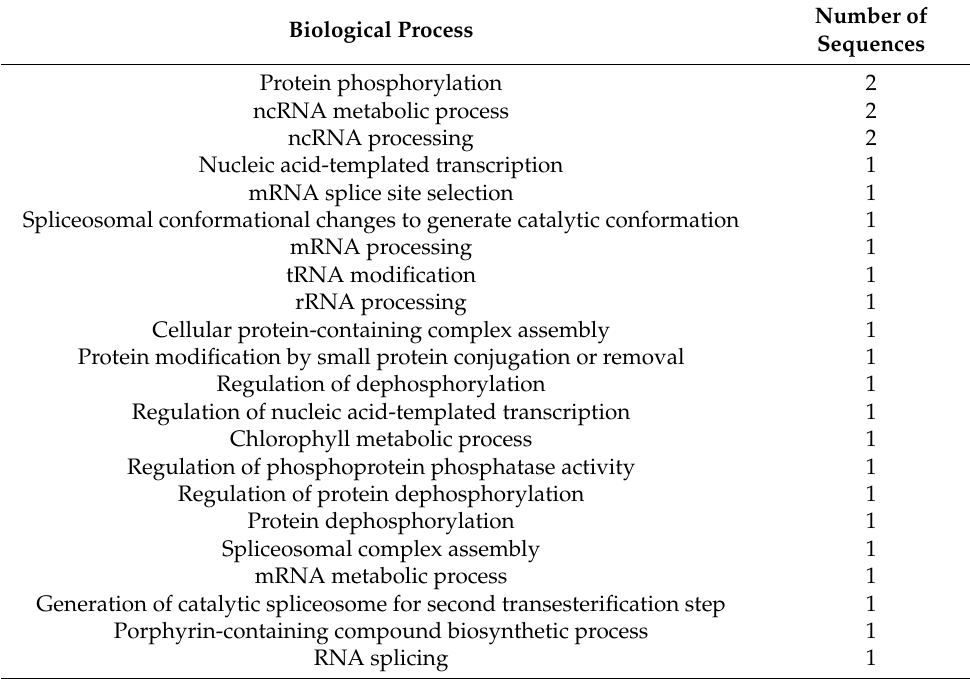
Table 8. Frequency of GO descriptions (GO term level 7) for the transcripts differentially expressed between inoculation and